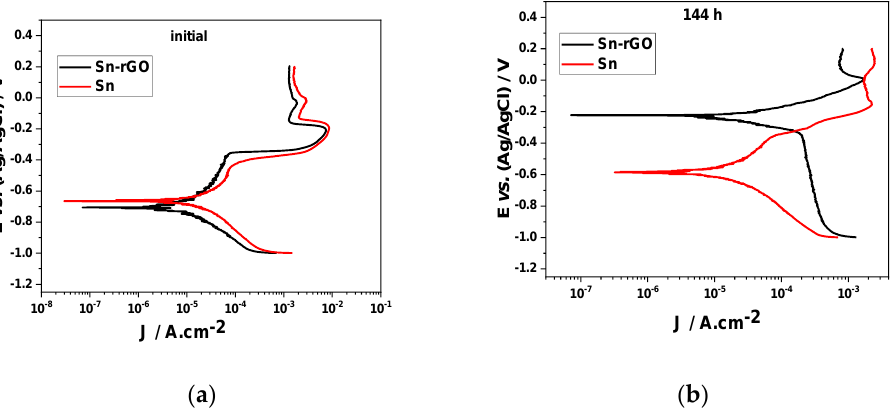
Figure 12. Polarization curves in semilogarithmic coordinates in 0.5 M NaCl for Sn and Sn-rGO composite coatings corresponding to the initial (a) and final (b) moments of immersion (25 °C, 1 mV s −1 ). Table 3. Values of corrosion parameters from polarization curves in 0.5 M NaCl for Sn-rGO and Sn coatings after different conditioning periods.